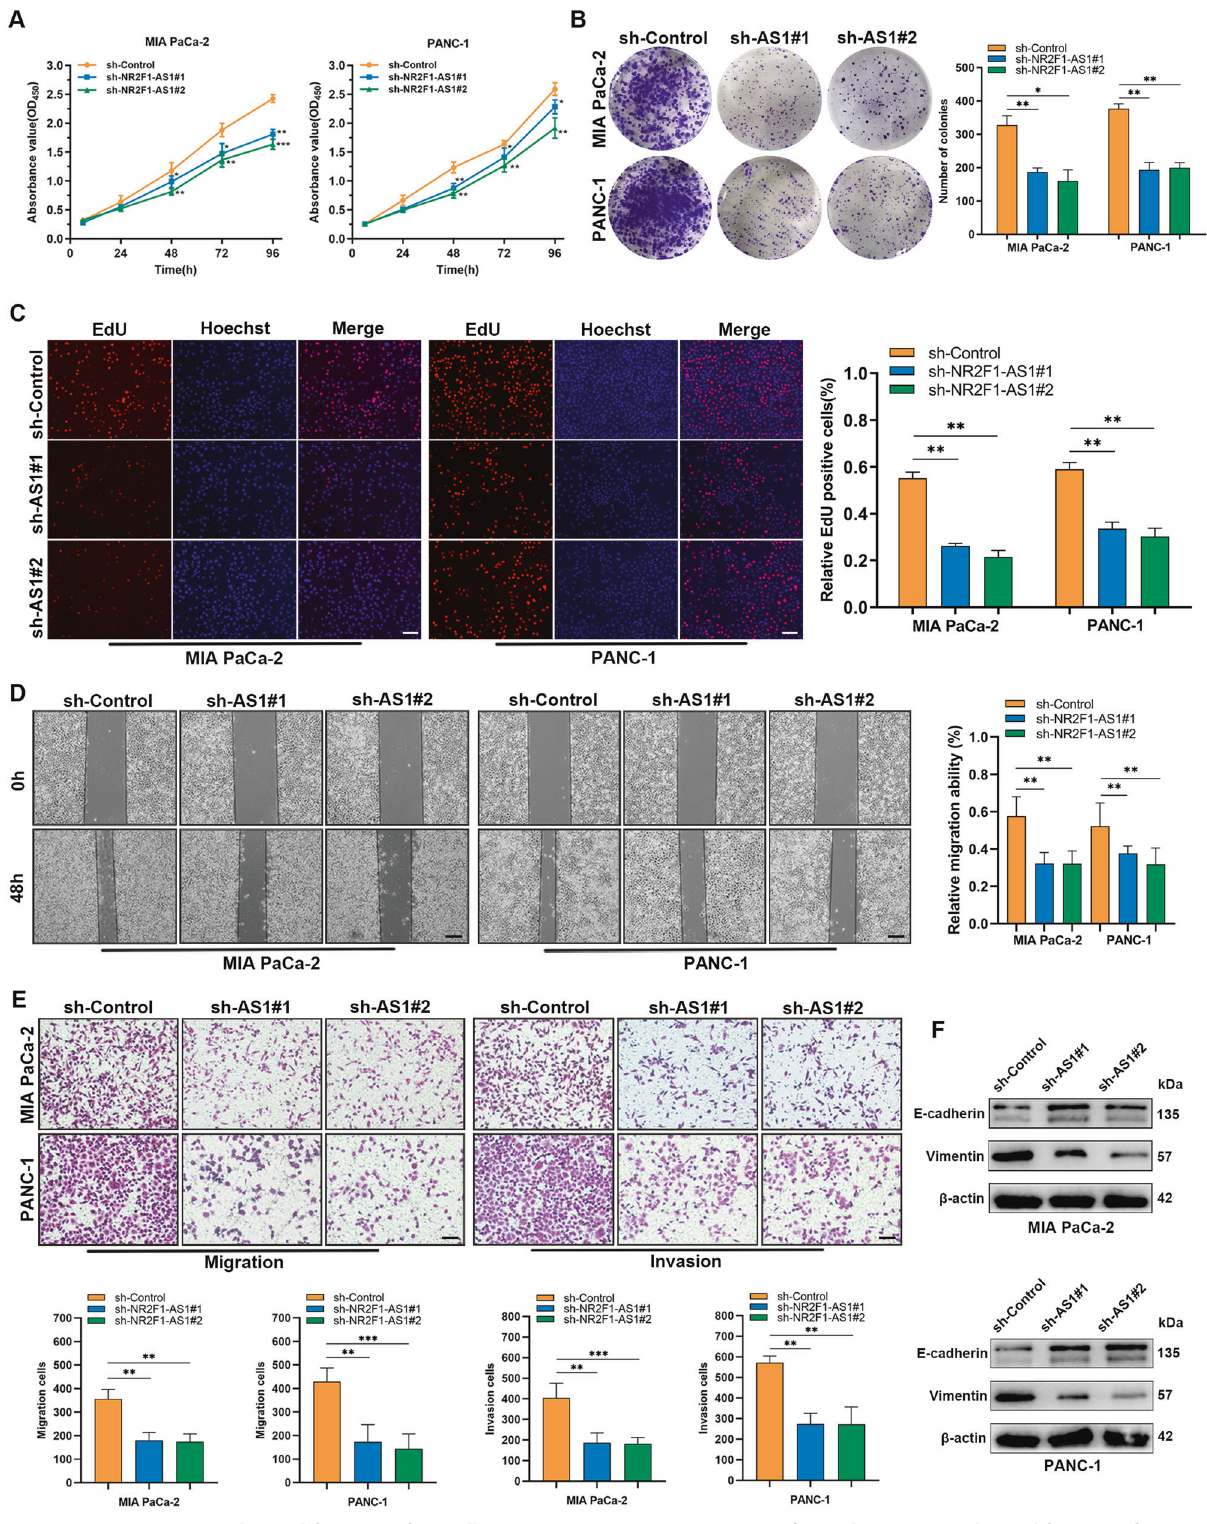
Fig. 2 NR2F1-AS1 promotes the proliferation of PC cells in vitro. A CCK-8 assays were performed to examine the proliferation of NR2F1-AS1- depleted MIA PaCa-2 and PANC-1 cells. B Representative images of colony-formation assays in NR2F1-AS1-knockdown and control MIA PaCa-2 and PANC-1 cells. C EdU proliferation assays in NR2F1-AS1-knockdown and control MIA PaCa-2 and PANC-1 cells. D Wound-healing assays in NR2F1-AS1-knockdown and control MIA PaCa-2 and PANC-1 cells. E Transwell assays were used to evaluate the migration and invasion abilities of NR2F1-AS1-knockdown and control MIA PaCa-2 and PANC-1 cells. F Western blot analysis of epithelial-to-mesenchymal transition markers in NR2F1-AS1-knockdown and control PC cells. Scale bar = 200 μ m. Data are expressed as mean ± SD. All experiments were repeated three times independently. * P < 0.05, ** P < 0.01, *** P < 0.001.